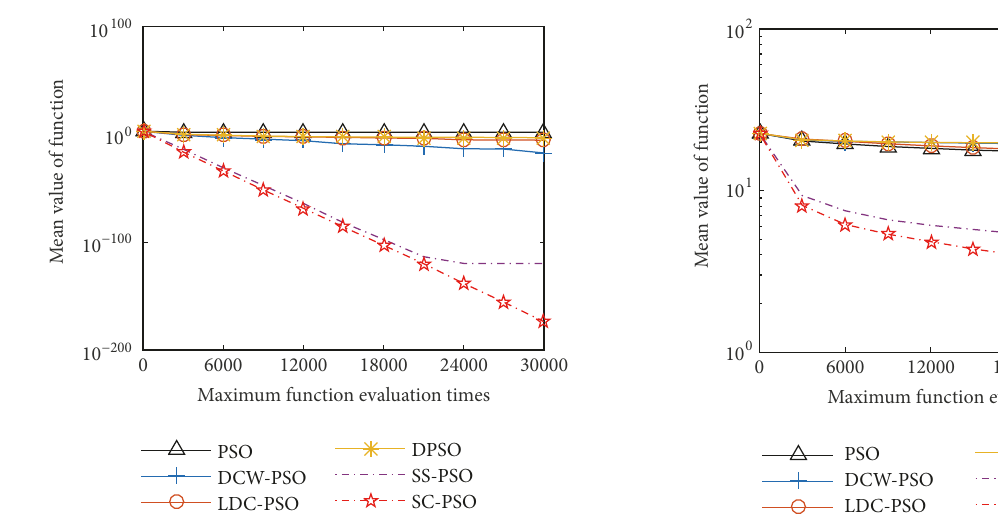
Figure 12: The function f 10 iterates over the